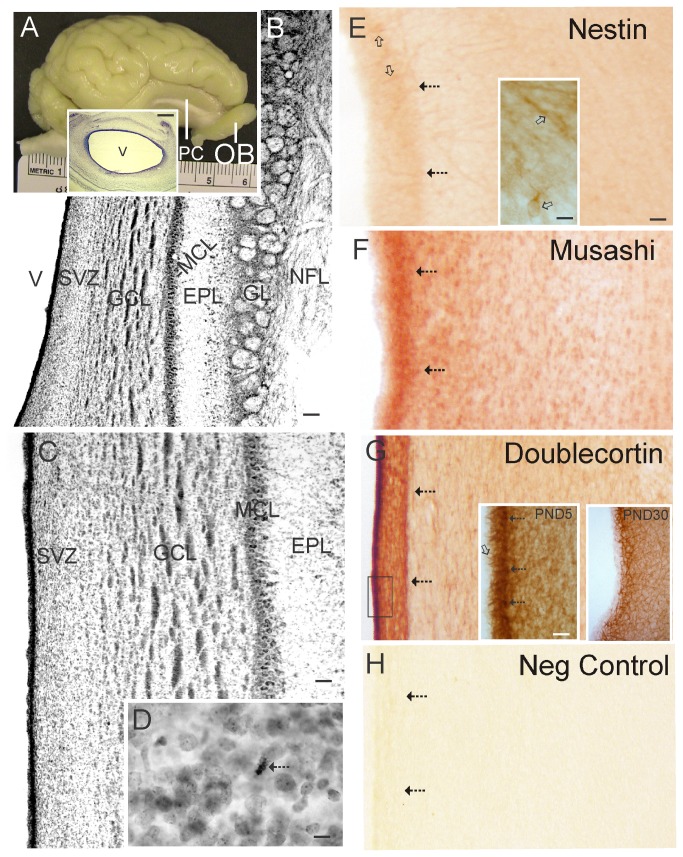
Piglet brain olfactory bulb (OB) gross anatomy, histology, and expression of neural stem cell and neuroprogenitor cell proteins.
A. Gross neuroanatomy of the 5-day-old piglet brain showing the gyrencephalic cortex, primary olfactory cortex (PC, also known as piriform cortex) and OB. Inset shows a Nissl-stained transverse section through the OB revealing the patent cerebroventricular cavity (V) and prominent subventricular zone (dark blue lining of the ventricle) containing the ependymal and subependymal layers. Scale bar = 1.1 mm. B. Nissl-stained transverse section revealing the architectural lamination of the OB. From the ventricle (V) outward the layers are: the SVZ, the granule cell layer (GCL), the mitral cell layer (MCL, the mitral cells project to the primary olfactory cortex), the external plexiform layer (EPL), the glomerular layer (GL), and the nerve fiber layer (NFL) that originates from the neuroepithelium of the olfactory mucosa. Scale bar = 100 µm. C. Higher magnification image showing the cellular detail of the wall of the OB. Scale bar = 33 µm. D. Nissl staining reveals the presence of mitotic figures (arrow) in the SVZ. Scale bar = 8.3 µm. E-G. Immunohistochemical localization of nestin (E), musashi (F), and doublecortin (G) in the OB. Immunoreactivity is seen as orange-brown staining. Arrows identify the subependymal layer. Open arrows (in E) identify nestin+ cells. Inset in E shows nestin+ cells (open arrows) at higher magnification. The large nucleus (pale oval) and sparse cytoplasm with prominent neurites is typical of a NSC. Insets in G show doublecortin immunoreactivity at the ependymal/subependymal layers (see box in G) at higher magnification in piglet OB at postnatal day (PND) 5 and 30. In PND5 inset the open arrow identifies doublecortin+ processes extending into the ependymal layer and hatched arrows identify doublecortin+ cell bodies in the subependymal layer. Scale bar in E (same for F-H) = 33 µm. Scale bars for insets = 12 µm (E) and 20 µm (G) H. Nestin primary antibody was preadsorbed against nestin synthetic peptide for a negative control. No staining is seen.